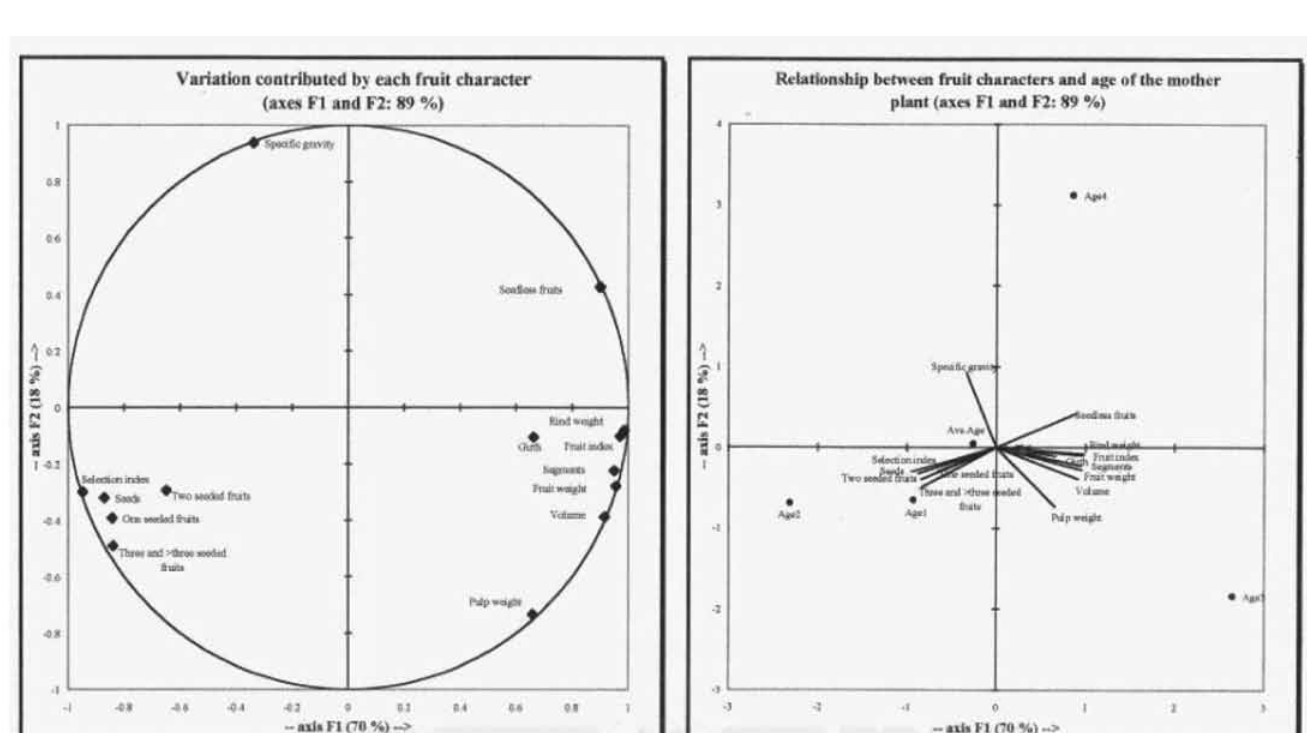
Fig. 2 - Plot showing the percentage of variation contributed by each fruit character and the relationship between age of the mother plant and fruit characters in mangosteen ( Garcinia